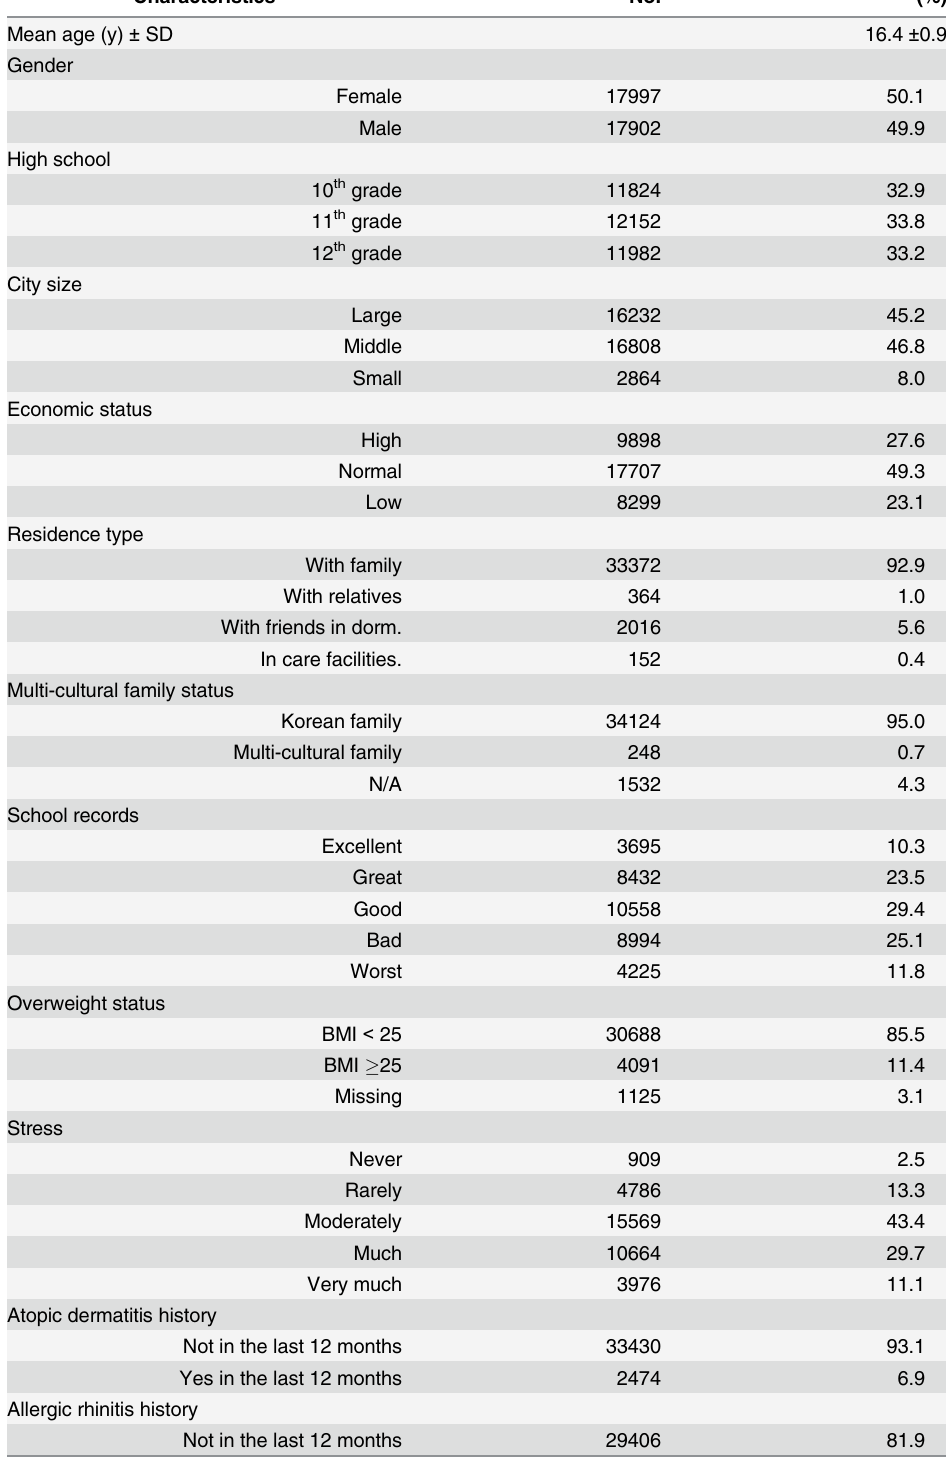
Table 2. Characteristics of the population sample composed of high school students in 2014 (n =